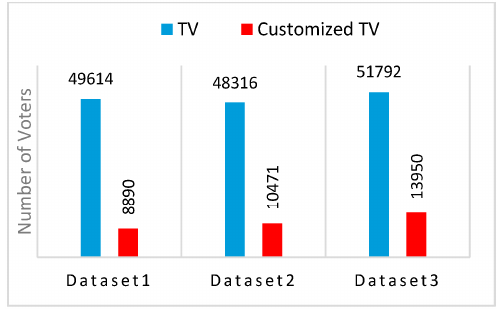
Figure 10. Comparison of computation efficiency of TV and Customized TV.